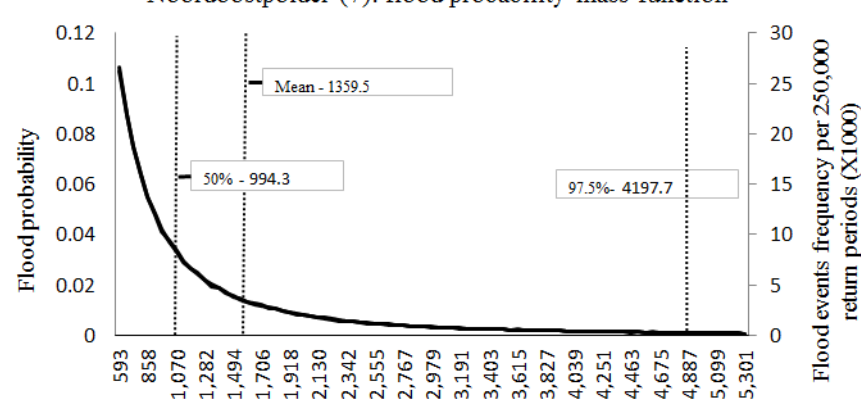
Figure 3: Simulated flood-damage density for the dyke-ring Noordoostpolder (7)